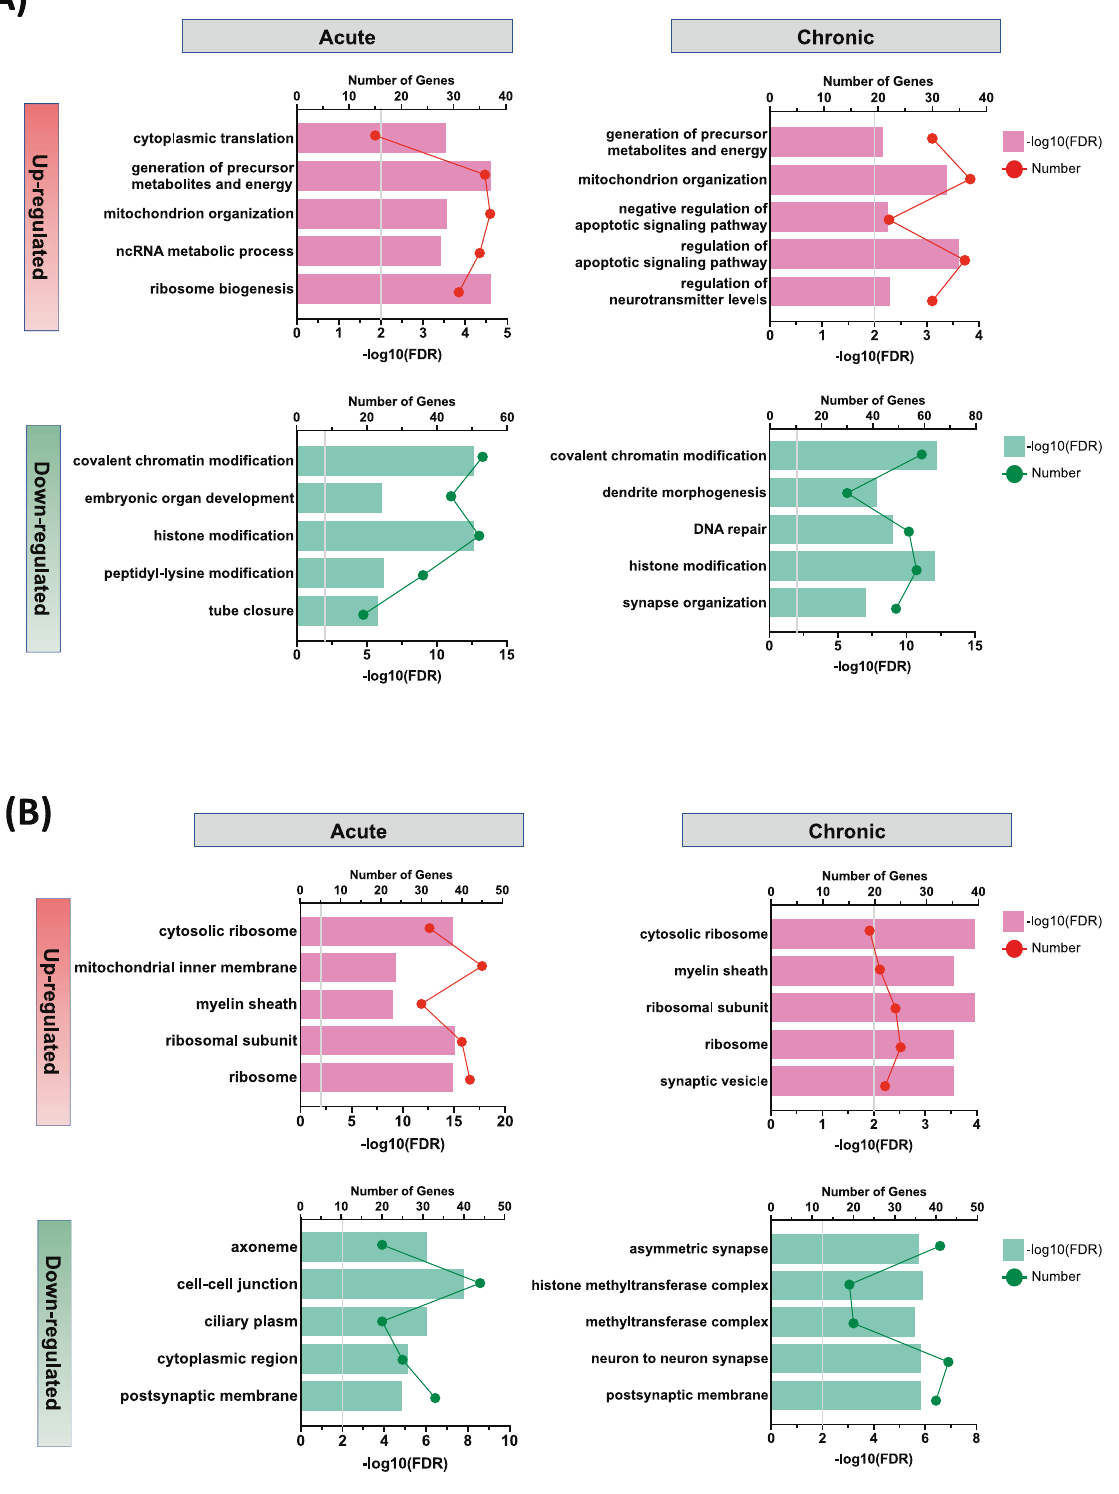
Fig. 2 GO enrichment analysis of DEGs in response to Acute and Chronic alcohol drinking. The ordinate represents the GO terms, the upper abscissa indicates the number of genes in the GO terms, and the lower abscissa indicates the level of signi fi cance of the enrichment (gray bar, FDR = 0.01). A Genes were categorized with the Biological Process domain. B Genes were categorized with the Cellular Component